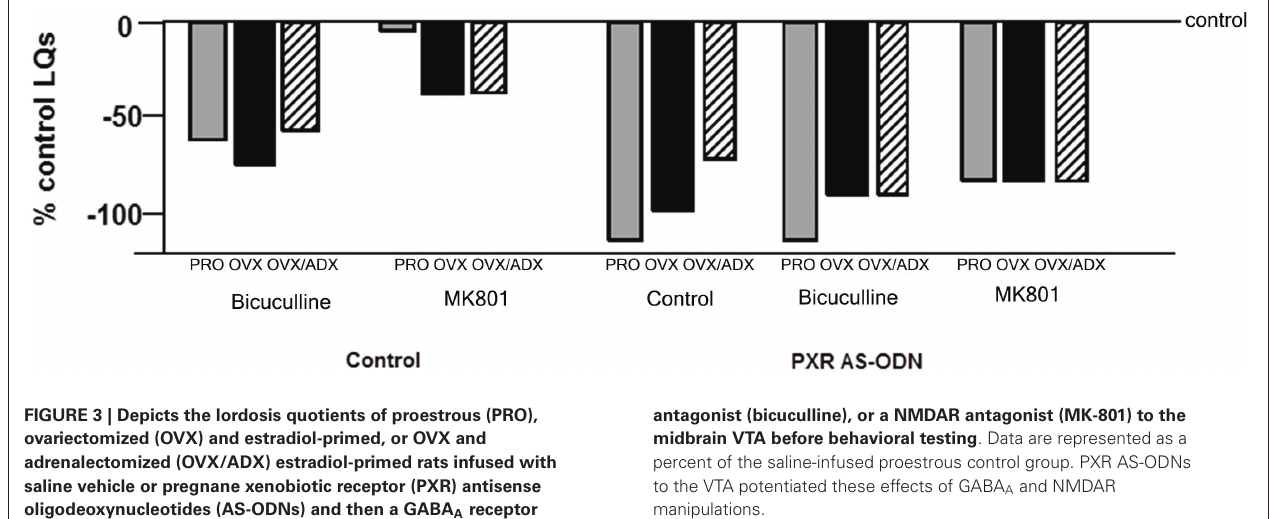
FIGURE 3 | Depicts the lordosis quotients of proestrous (PRO), ovariectomized (OVX) and estradiol-primed, or OVX and adrenalectomized (OVX/ADX) estradiol-primed rats infused with saline vehicle or pregnane xenobiotic receptor (PXR) antisense oligodeoxynucleotides (AS-ODNs) and then a GABA A receptor